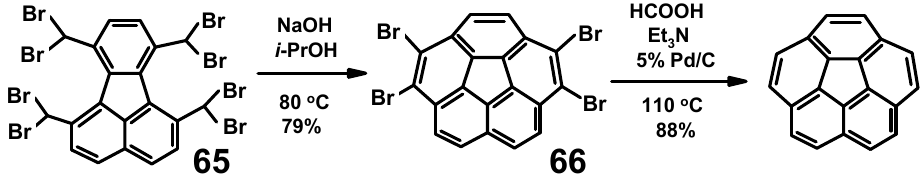
Scheme 23. Key steps in Siegel’s kilogram-scale synthesis of